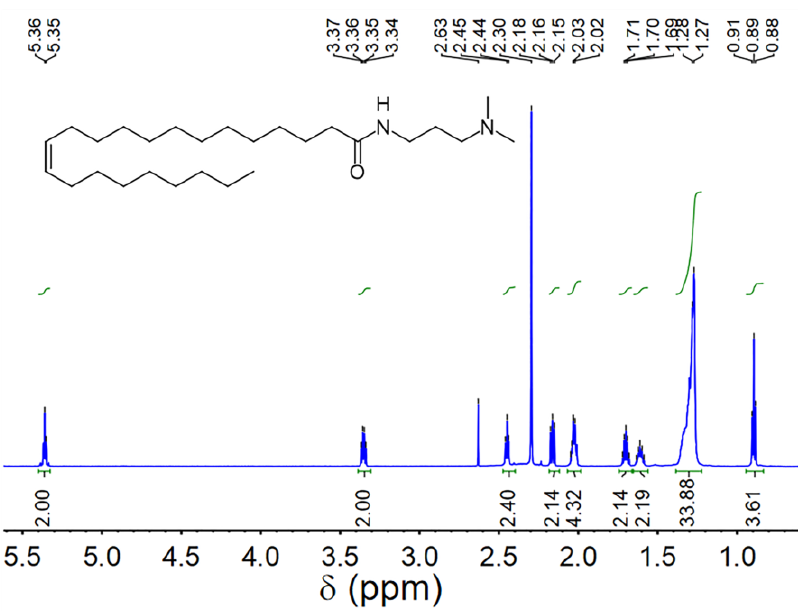
Figure 9. 1 H NMR spectrum of UC 22 AMPM (400 MHz, CDCl 3 ).